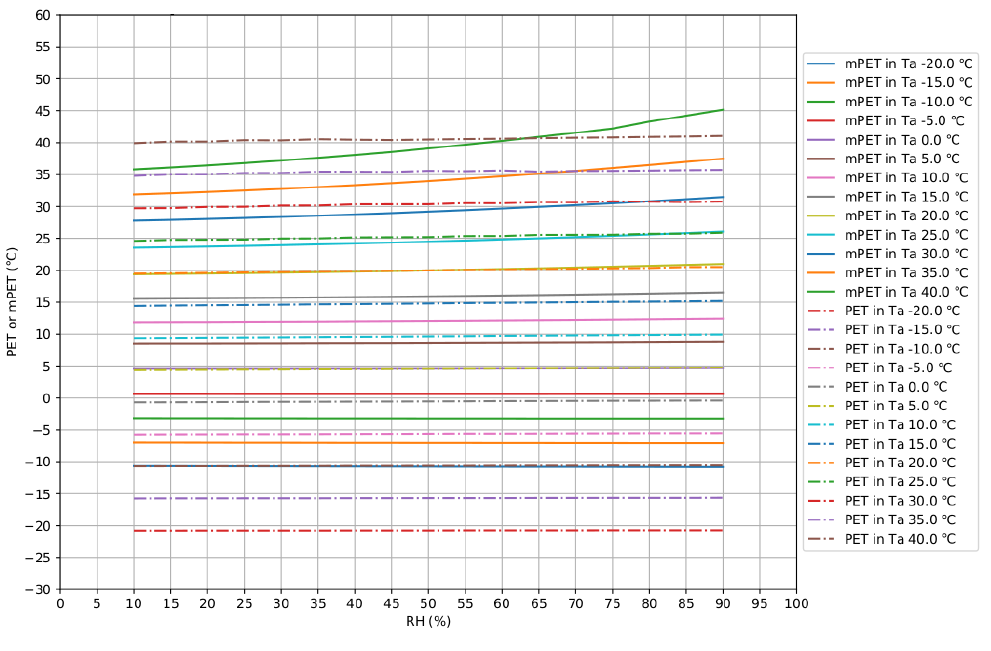
Figure 7. The comparison of PET and mPET in different T a and RH .